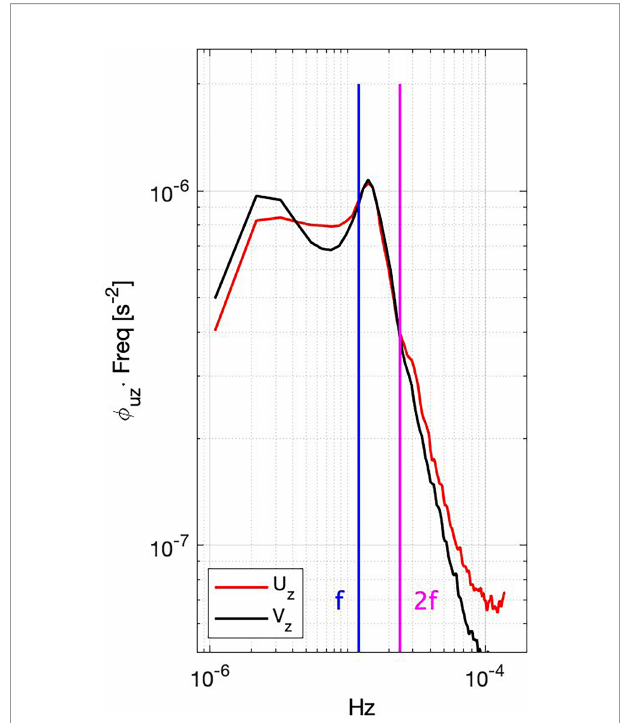
FIGURE 13 | Mean Lagrangian shear spectra for (black) meridional and (red) zonal velocity shear. The vertical lines (blue and magenta) indicate the range between f and 2 f , where f is Coriolis frequency. Note that spectra is in variance preserved form (s -2 ). The 1835 particles out of 9000, with mean speeds more than 0.45 m s -1 and last more than 58 hours in the nested model domain, are chosen to compute the mean